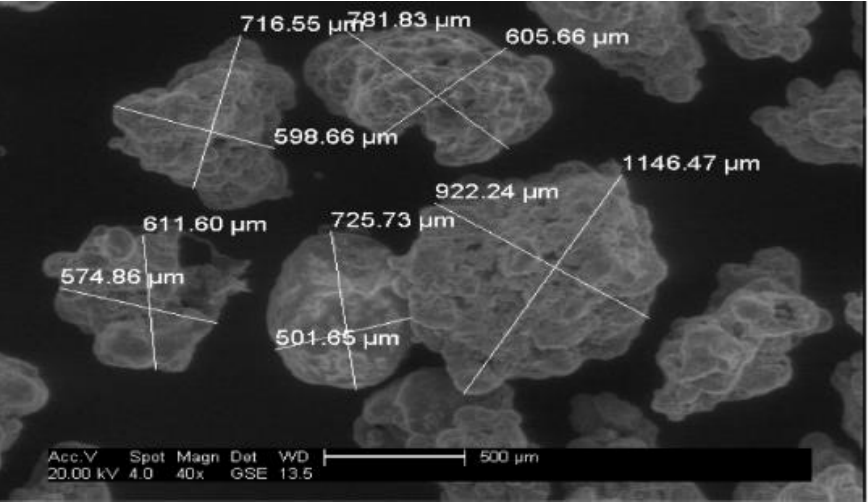
Figure 7. A microscopic image of the washing powder compound [27]. Using a DoE approach, surrogate materials were chosen to represent the particles with regular and irregular geometries, glass beads and polyethylene particles, respectively, which were sieved into various sizes to form desired mixtures. Images of the glass beads and polyethylene particles can be seen in Figures 8 and 9.